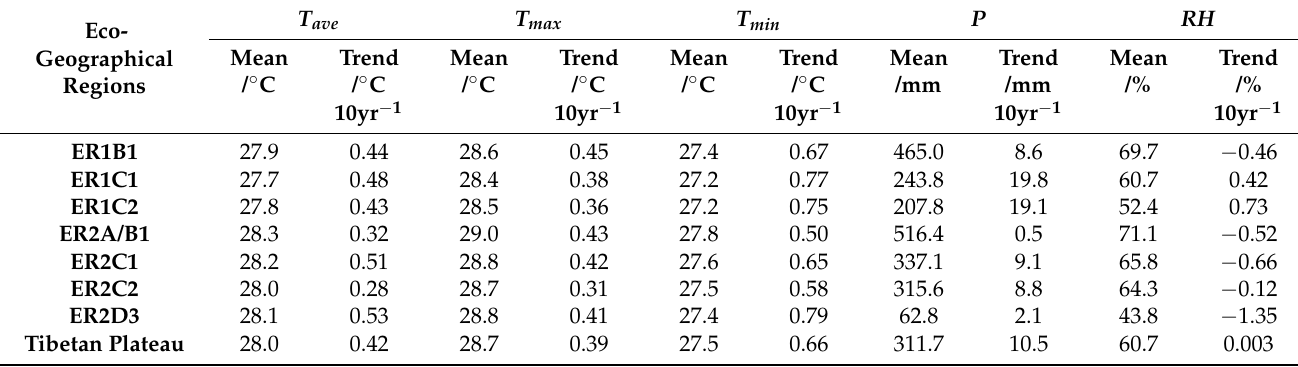
Table 3. Climatic variables and trends in ecoregions of Tibetan Plateau during the growing season of 1982–2015. Eco- Geographical